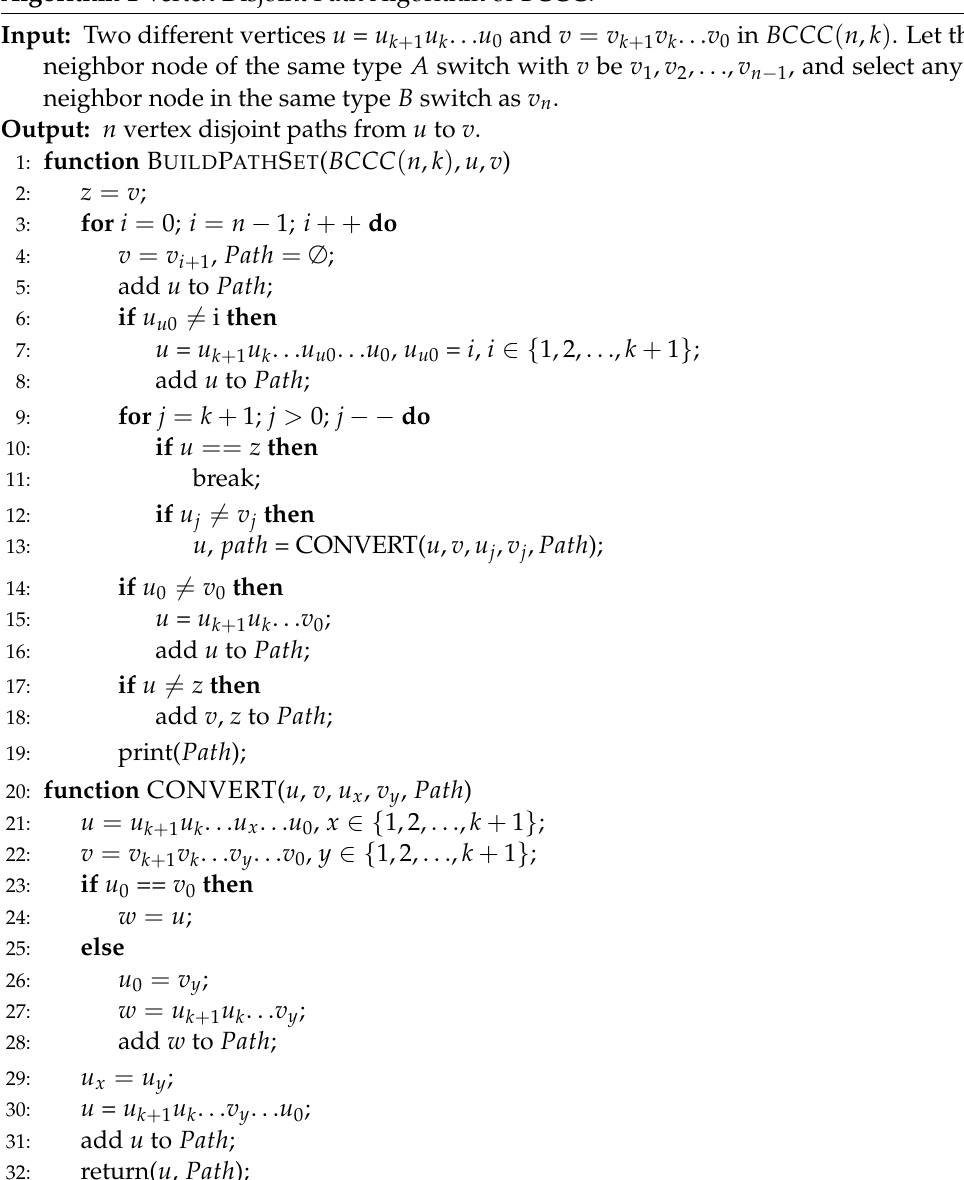
Algorithm 1 Vertex Disjoint Path Algorithm of